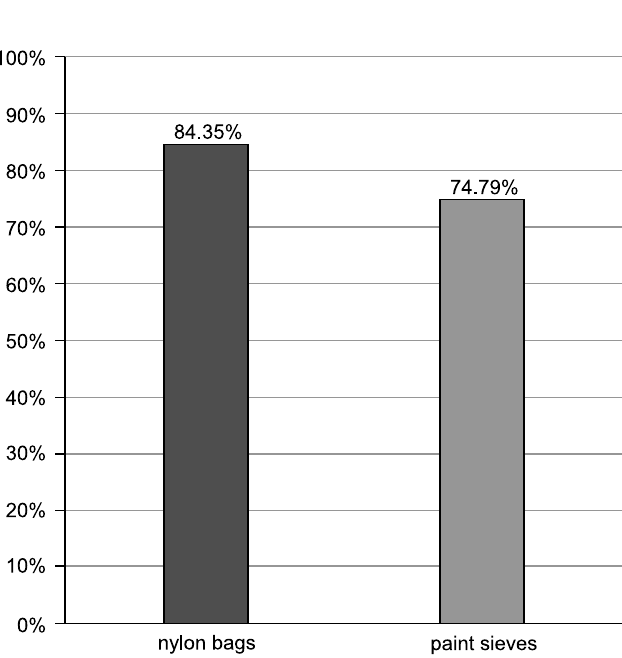
Fig. 2. Comparison of mass reduction between the nylon mesh bags and the paint sieves. The numbers reported are averages from all samples. The orig- inal matrix lithology was a sandy siltstone with calcite cement and swelling bentonitic clay collected from the Morrison Formation, an Upper Jurassic terrestrial deposit. This material was collected from the Two Sisters 2 Quar- ry, a fossil vertebrate locality in northern Wyoming, USA. Approximately 15 kg of original matrix was processed using the paint sieve method, and approximately 10 kg of original matrix was washed using the nylon